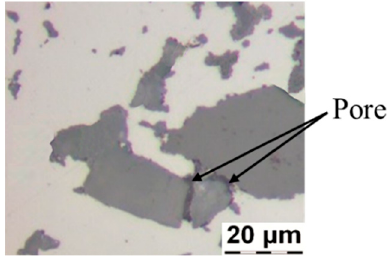
Figure 6. Pores generated within the matrix of the 20% ZrO 2 specimen owing to particle cluster formation.